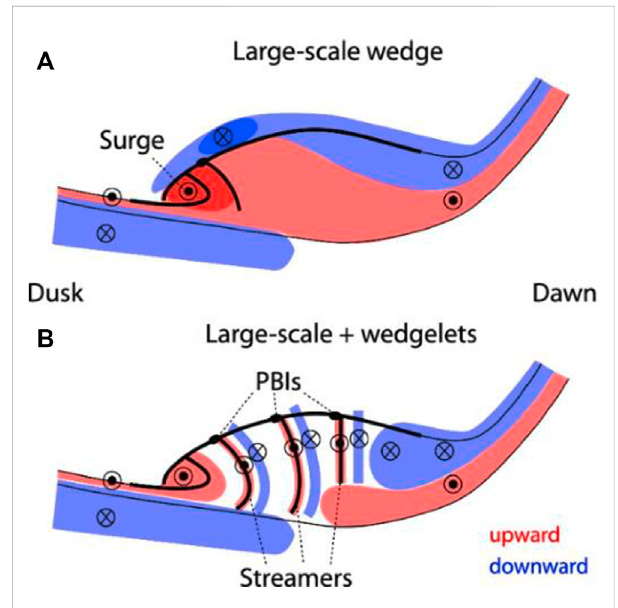
FIGURE 4 From Nishimura et al. (2020) (A) Schematic of large-scale SCW. (B) Schematic of SCW formed by a compilation of wedgelets.